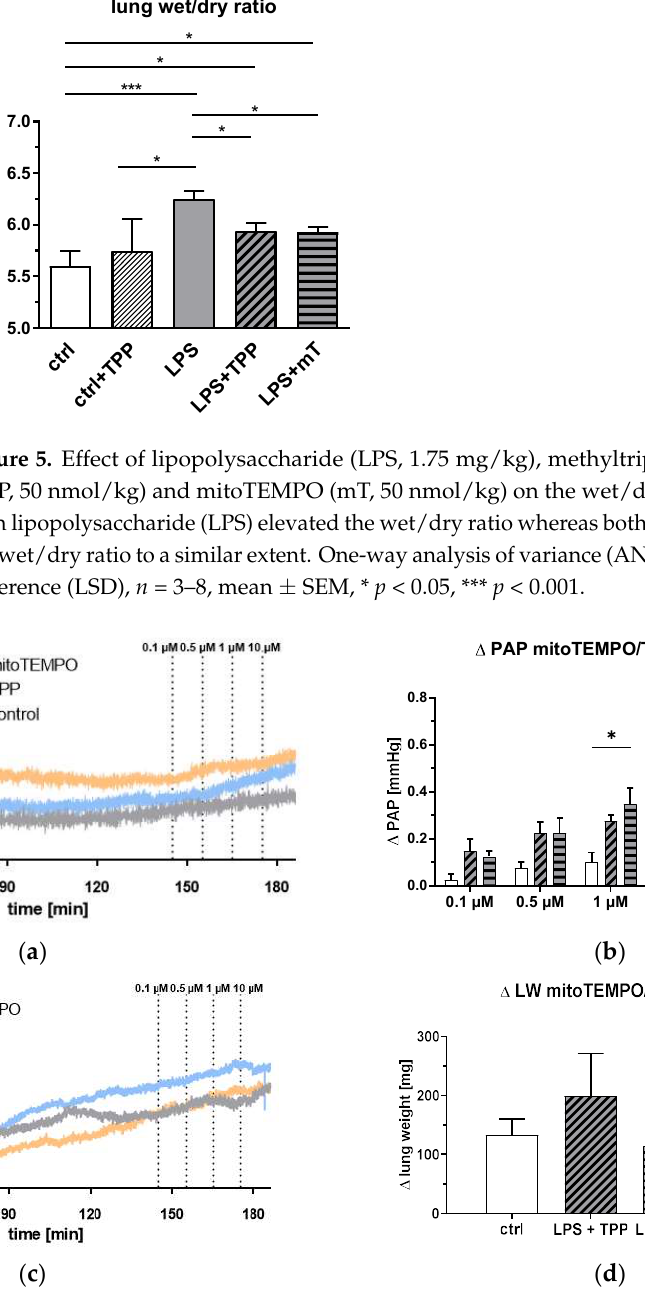
Figure 6. Isolated blood free perfused lung. Pulmonary arterial pressure (PAP) and lung weight (LW) in response to lipopolysaccharide (LPS, 6 µg/mL), methyltriphenylphosphonium chloride (TPP), and mitoTEMPO (mT) treatment. Course of PAP increase ( a ) or weight gain ( c ) after the start of the experiment (mean values of n = 4 isolated lungs each experiment). PAP increase ( b ) after repetitive application of mitoTEMPO/TPP and weight gain ( d ) after the last application of mitoTEMPO/TPP. Two-way analysis of variance (ANOVA) with Tukey’s post hoc test, n = 4 each group, mean ± SEM, * p < 0.05, ** p < 0.01.